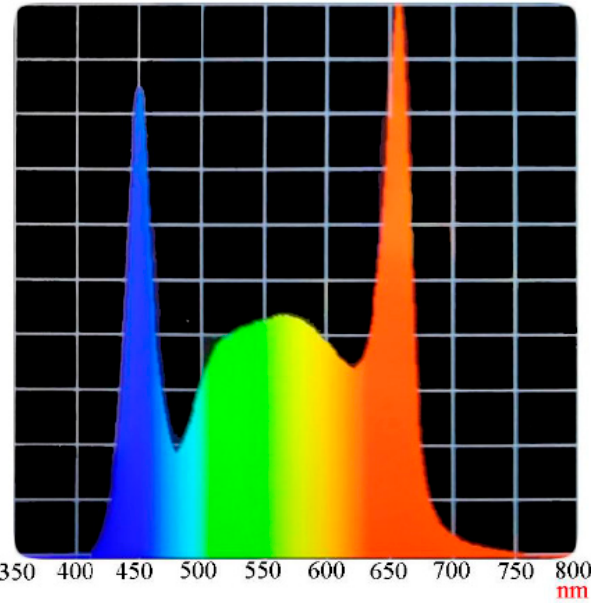
Figure 2. LED light